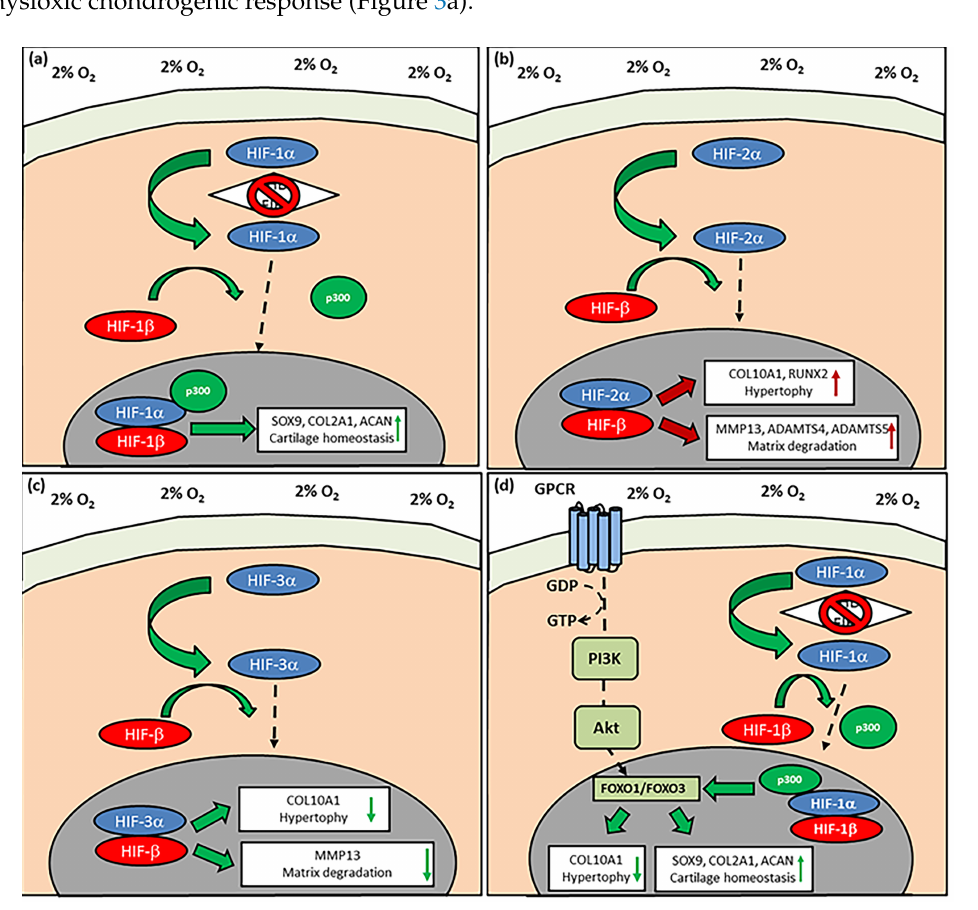
Figure 3. The pathways controlling the response of physioxia MSC chondrogenesis. ( a ) HIF-1 α upon translocation into the nucleus and dimerization with HIF-1 β leads to upregulation of chondrogenic matrix gene expression, whereas ( b ) HIF-2 α nuclear translocation and dimerization results in an upregulation in cartilage hypertrophic and matrix degradation enzyme gene expression. The effect of HIF-2 α can be countered by the upregulation of ( c ) HIF-3 α , which upon activation, counters the upregulation in hypertrophic and matrix degradation gene expression. ( d ) The PI3K/Akt/FOXO pathway is activated under physioxia in response to HIF-1 α translocation and helps to maintain chondrocyte phenotype via reduction in chondrocyte hypertrophy markers (green arrow direction symbolizes positive upregulation or downregulation in chondrogenic or hypertrophic genes; red arrow direction symbolizes negative upregulation in hypertrophic and matrix degradative enzyme gene expression; dotted arrow depicts HIF-1 α , HIF-2 α or HIF-3 α nuclear